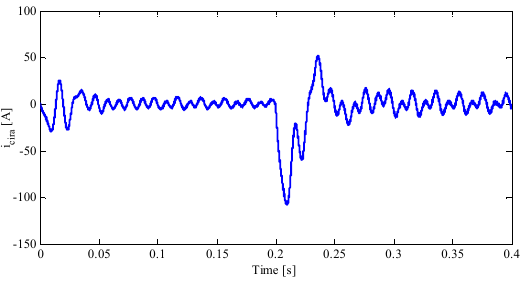
Figure 20. Circulating current of MMC in phase “a” with input MMC current variations.